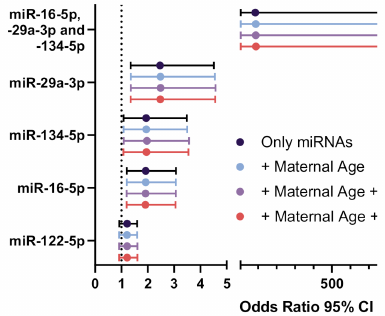
Figure 3. Odds ratios for the association of miRNAs with GDM. Odds ratio plot showing the predictive effects of either a single miRNA, a combination of these, or miRNAs after adjustment for confounding variables such as maternal age and BMI and offspring sex on GDM diagnosis.